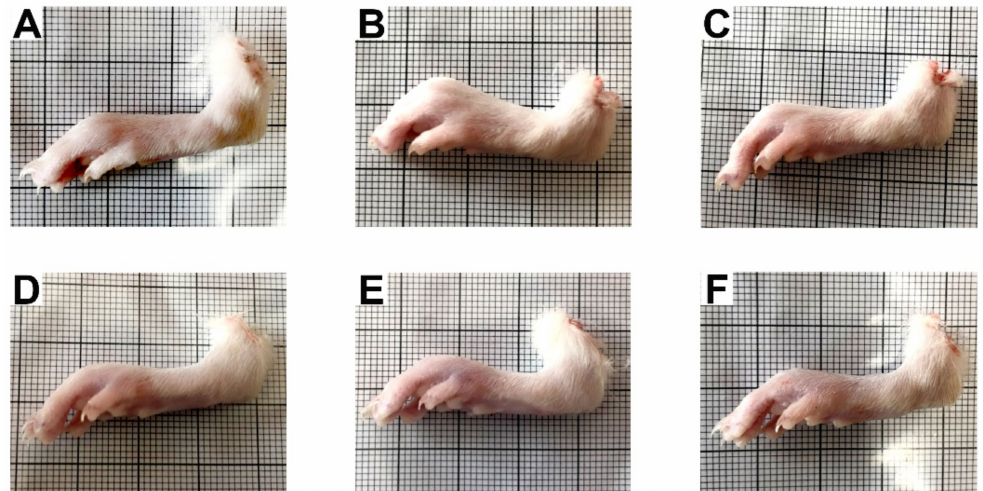
Figure 2. Gross pathological changes of hind paws of rats pretreated with vehicle (0.9% saline), ibuprofen (100 mg/kg), or ZO essential oil at different doses at 6 h after carrageenan injection. ( A ) Normal control group (no carrageenan injection); ( B ) control group; ( C ) ibuprofen group; ( D – F ) 200, 400, and 800 mg/kg of ZO essential oil groups.